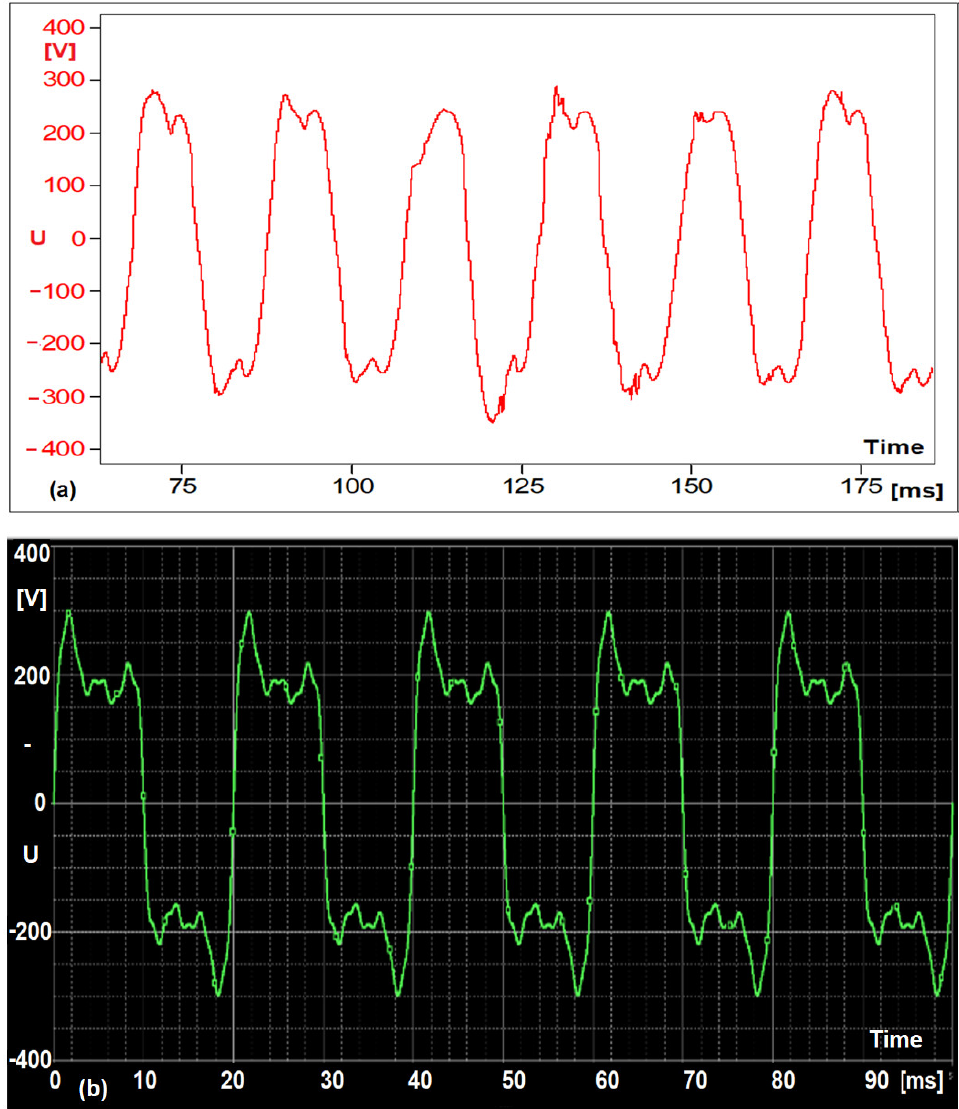
Figure 16. Electric arc voltage oscillograms recorded in real conditions ( a ) and determined using the proposed model ( b )—initial stage of melting [31].